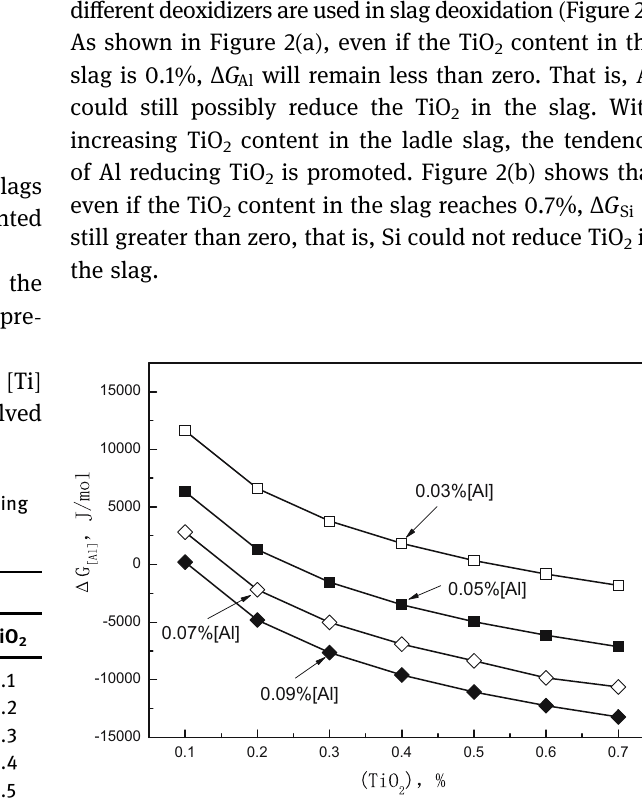
Figure 1: Variation in Gibbs free energy of the reaction between [ Al ] and TiO 2 in the slag at 1,873